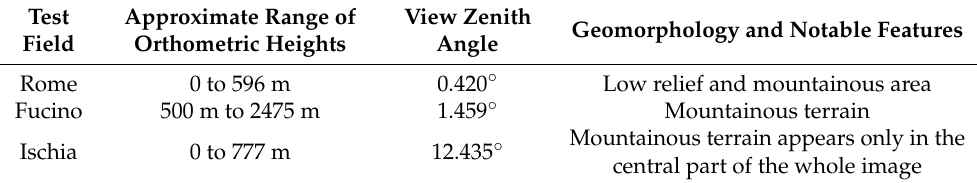
Table 1. Main features of PRISMA